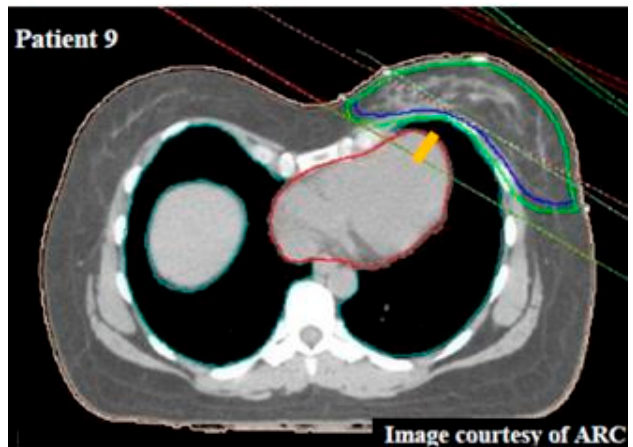
Figure 2. Maximum heart distance (MHD) (yellow) measured for patient 9 (deep inspiration breath hold (DIBH) plan) was 1.2 cm demonstrating the close proximity of the heart (red) in relation to the anterior left chest wall (clinical (blue) and planning (green) target volume (image courtesy of ARC)).